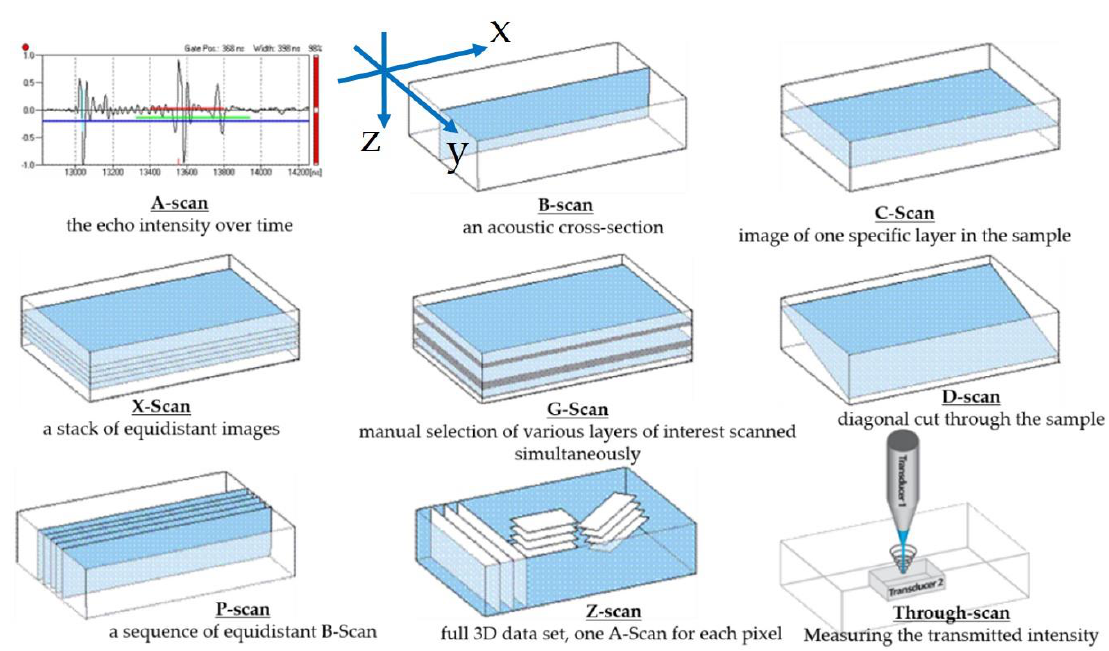
Figure 3. Scan modes of SAM (image courtesy of PVA TePla Analytical Systems).